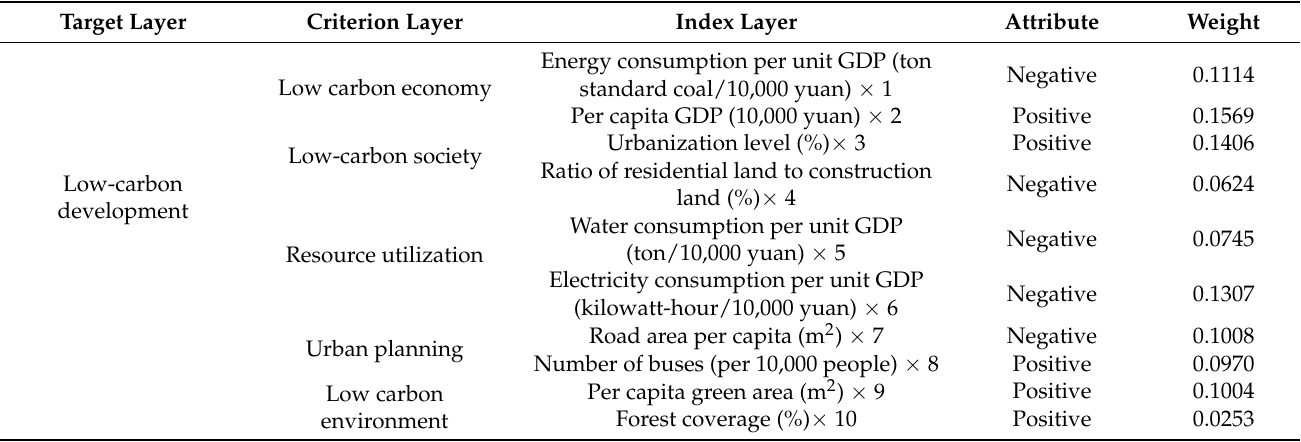
Table 1. The index group and